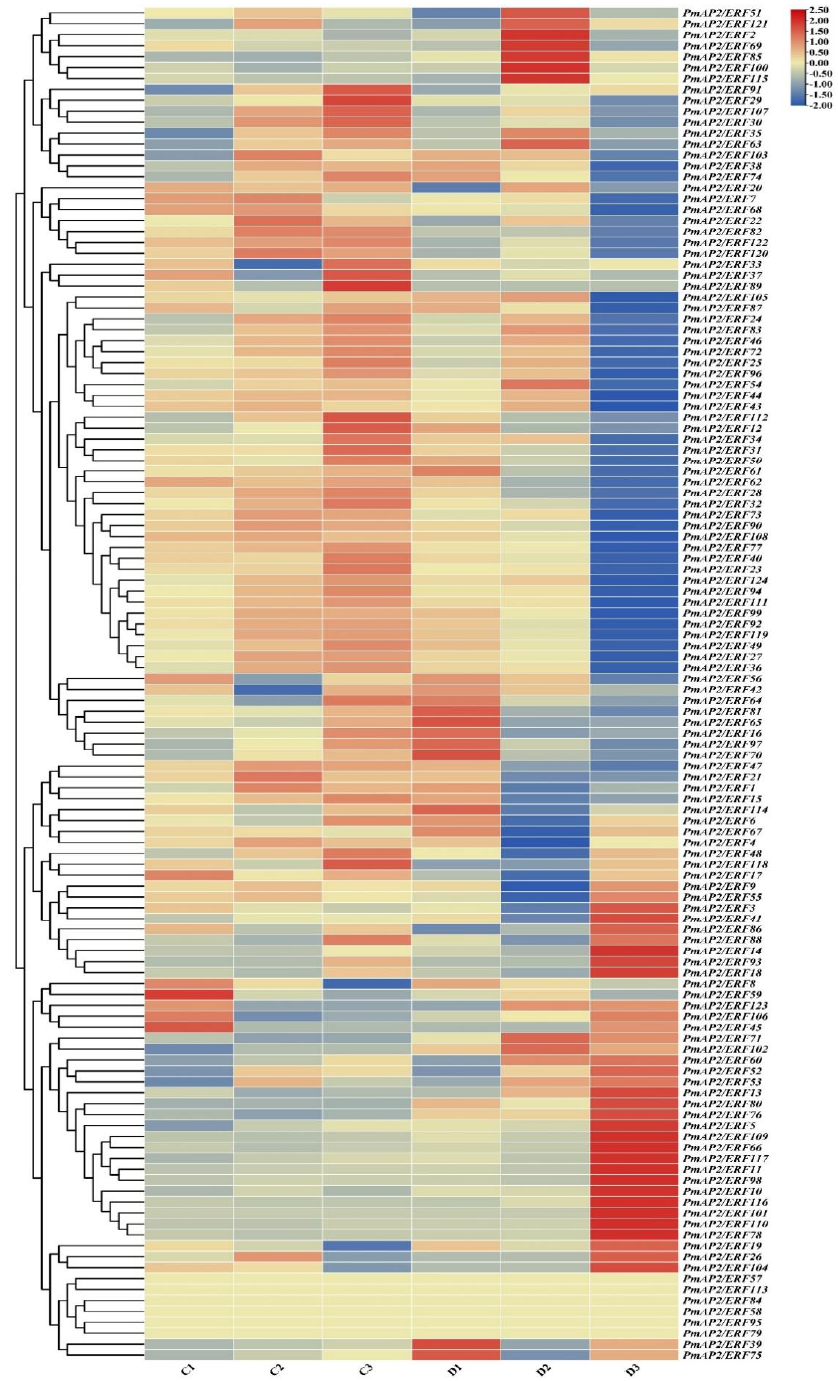
Figure 5. Expression heat map of PmAP2/ERFs gene expression in RNA-seq data. Blue represents low expression levels and red represents high expression levels. C and D indicate control (normal growth) and treatment (drought stress) groups, respectively; 1, 2, and 3 indicate control and drought treatment groups on the 7 th day, 8 th day rehydration at 7 h, and 8 th day, respectively. Gene expression heat map was plotted using TBtools.